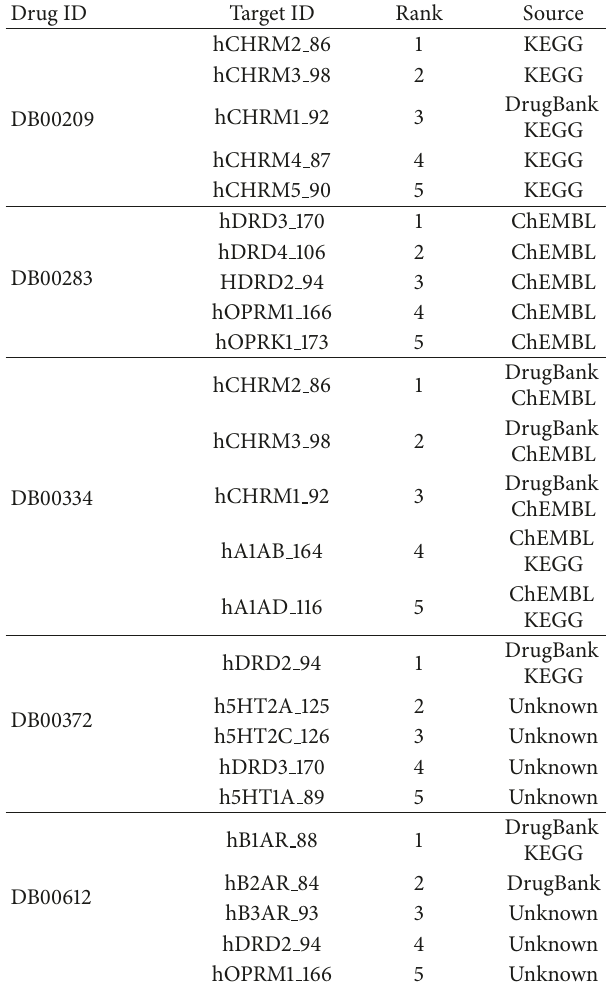
on dataset ExGPCRs, and its known DTIs are not used as a priori knowledge when conducting external validation.